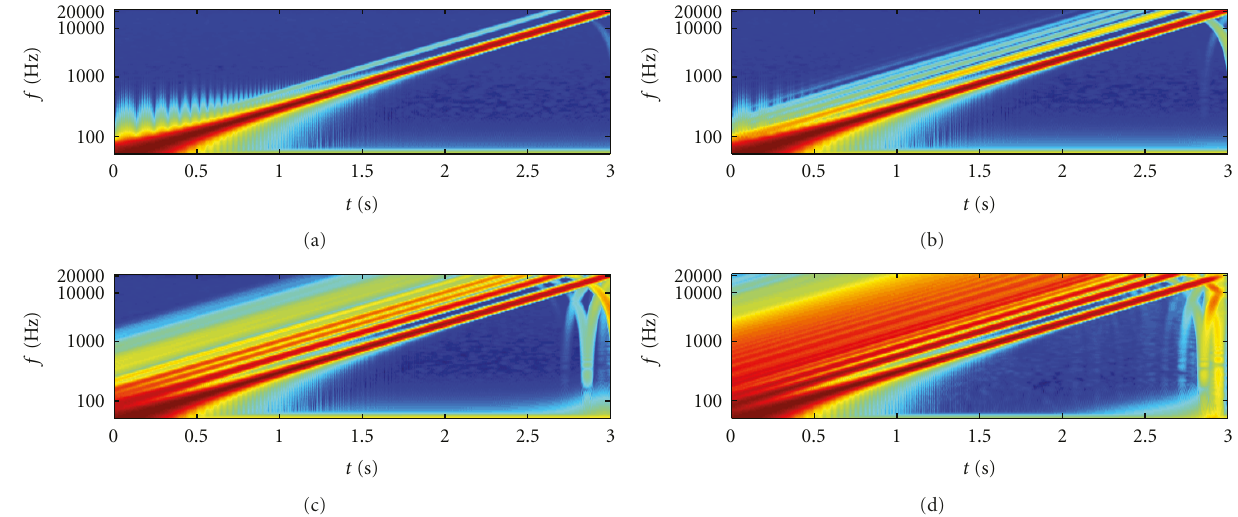
Figure 7: Simulation results for a logarithmic sweep signal. The plate voltage signals p 1 , p 2 , p 3 , and p 4 are displayed. The 32-x oversampling was used to reduce aliasing.